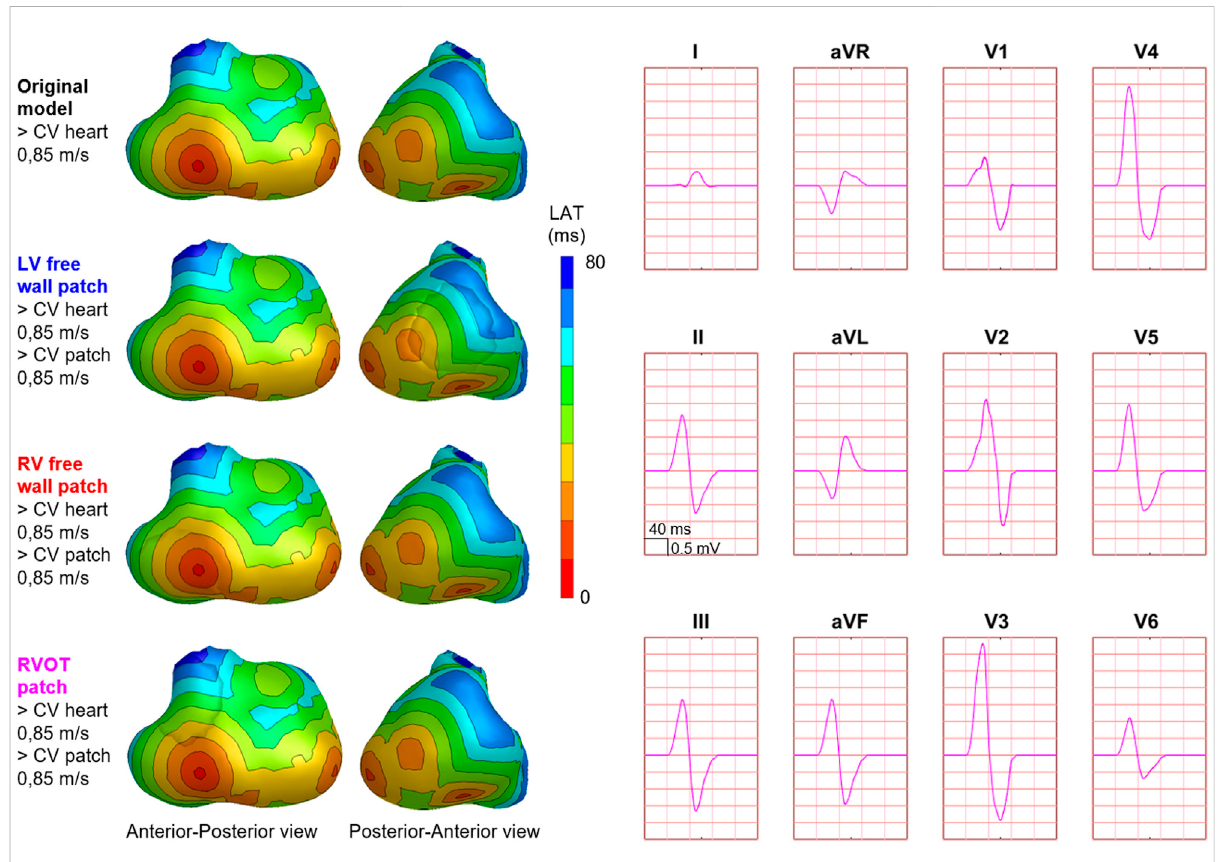
FIGURE 3 Effect of patch incorporation within the ventricular model. For both the original model and three of the models with patch, normal ventricular and patch activation were computed. Activation sequences were displayed from red (early) to blue (late). All simulated BSP signals overlap, as can be observedinthepresentedstandard12-leedECG.Onecubeinthe12-leadECGcorrespondsto40 ms(width)and0.5 mV(height)asalsoindicatedin lead